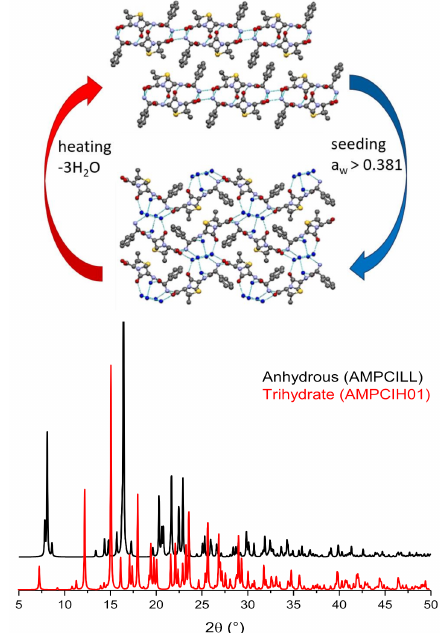
Figure 15. ( Top ): packing comparison and interconversion process between anhydrous and trihydrate ampicillin (refcodes AMCILL and AMPCIH01, respectively). ( Bottom ): comparison between the powder diffractograms calculated on the basis of the single-crystal data, showing the difference between the two